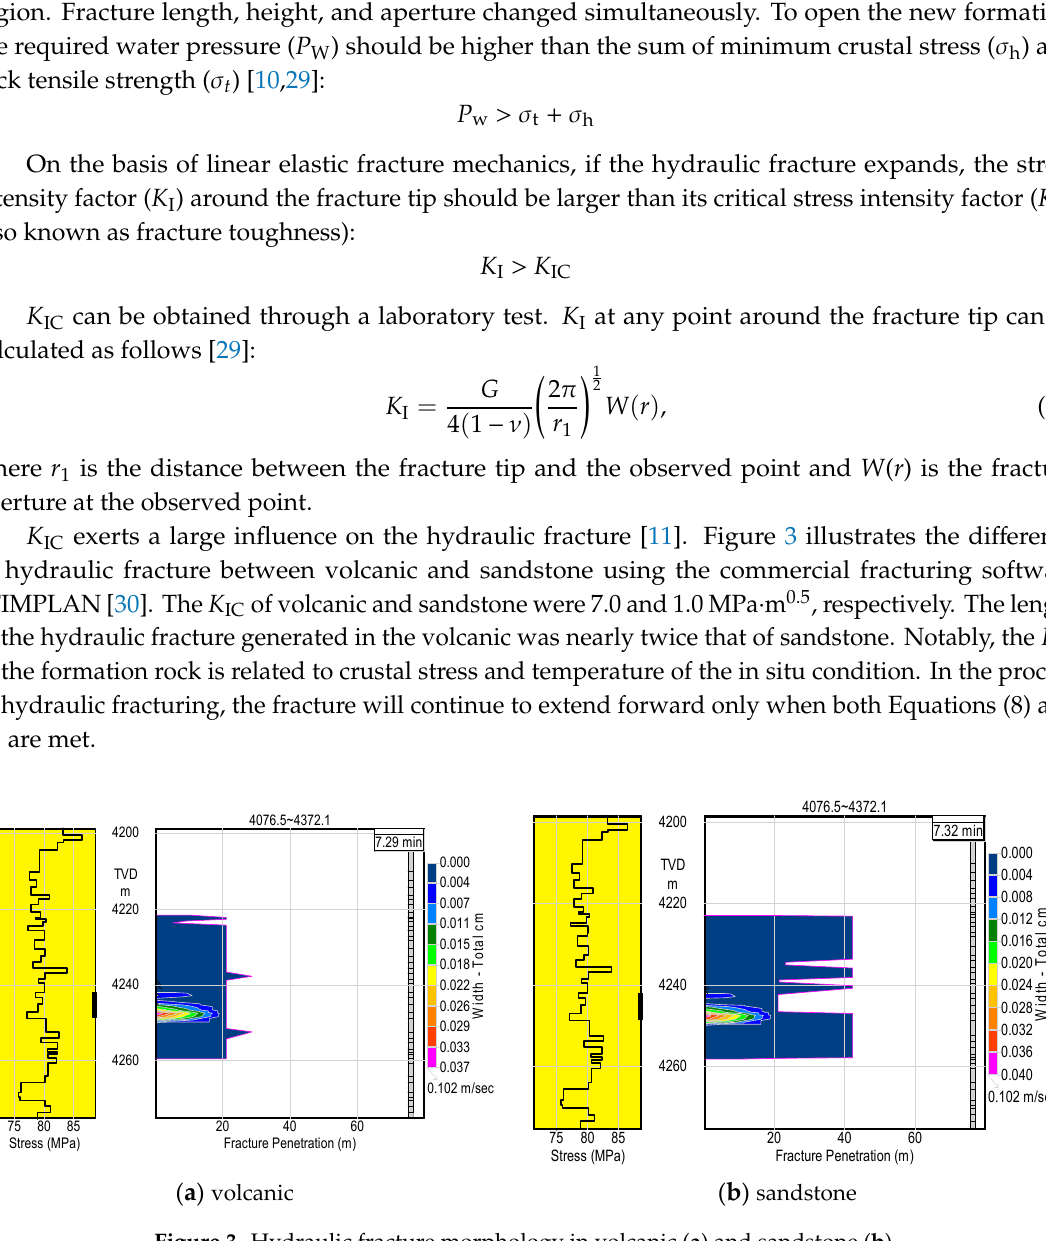
Figure 3. Hydraulic fracture morphology in volcanic ( a ) and sandstone ( b ).